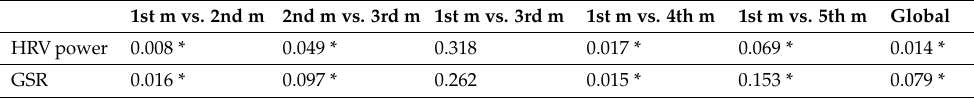
Table 10. Experiment 3 p -values ( p -value below the threshold of 0.05 is marked with